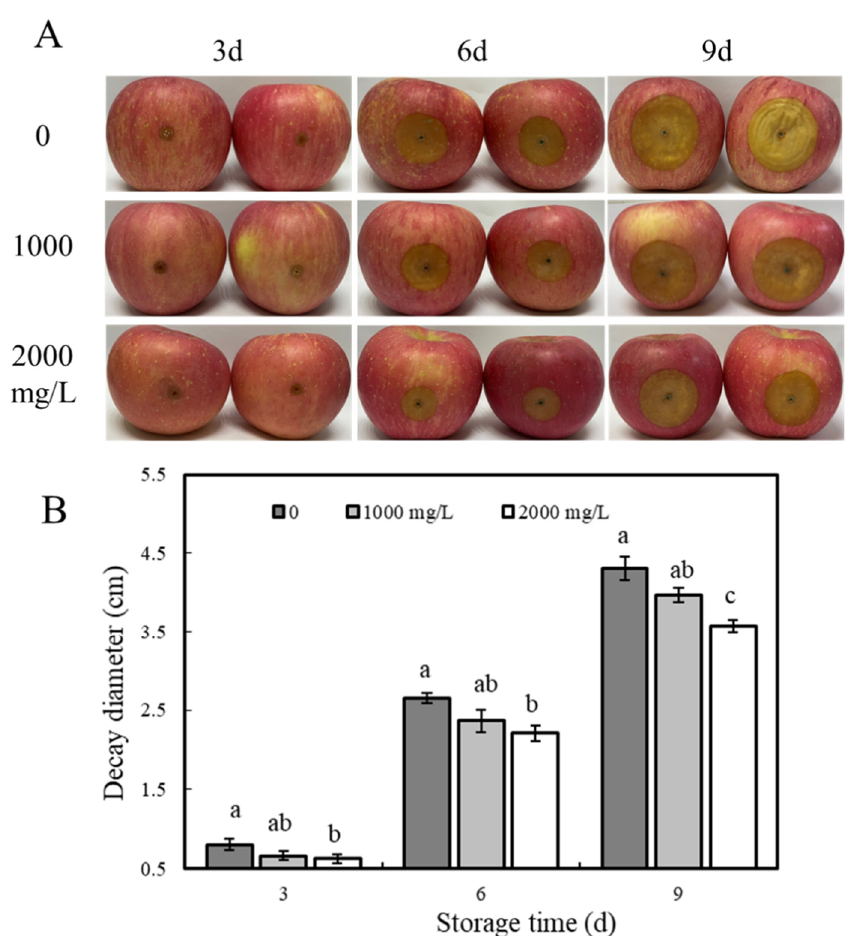
Figure 2. Effect of ε -PL treatment on the infection of P. expansum in apples after harvest. ( A ) Apple fruits were wound-inoculated with 10 µ L spore suspension of P. expansum at 1 × 10 4 spores/mL, then treated with ε -PL at different concentrations (0, 1000, and 2000 mg/L) for storage at room temperature. Lesion diameters ( B ) were recorded after inoculation every 3 days. The vertical bar represents the standard deviation (n = 3). Different letters indicate significant different according to Tukey’s test ( p < 0.05).